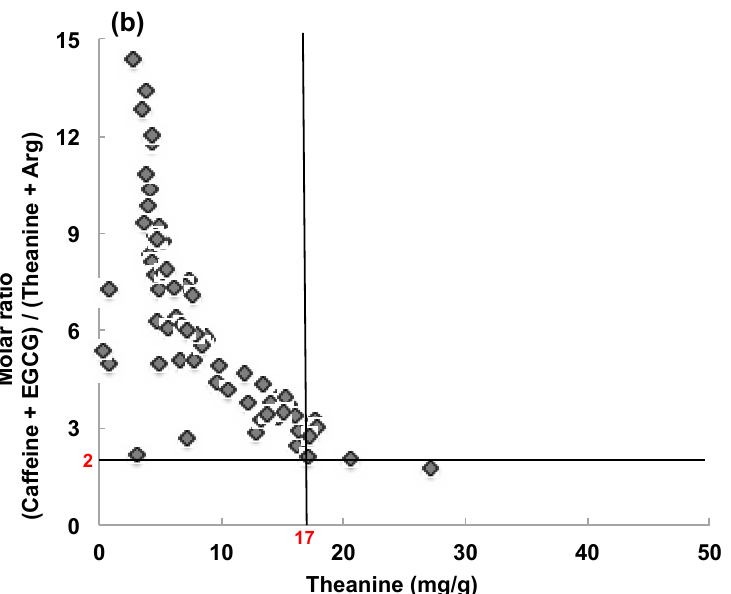
Figure 5. The amount of theanine and the molar ratio of caffeine and EGCG to theanine and Arg in ( a ) 76 samples of matcha marketed in Japan and ( b ) 67 samples of matcha marketed overseas. Based on data in humans, samples in the section, theanine > 17 mg/g, and molar ratio of caffeine and EGCG to theanine and Arg < 2 are expected to show a stress-reducing effect.